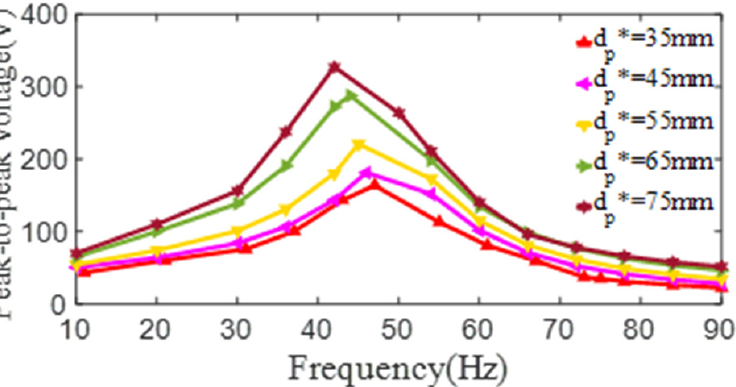
Figure 15. The relationship curves of the peak-to-peak voltage and the excitation frequency of PZT4 patch with different inner diameter ( D p * = 80 mm, t p * = 1 mm, t s * = 0.6 mm).